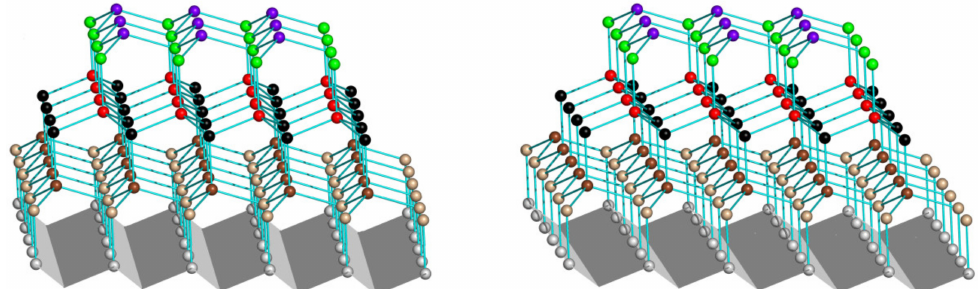
Figure 4. A stereo drawing of a piece of “normal” hexagonal ice (ice I h , [24]) on a corrugated underlying surface (highlighted in gray) fitted to basal planes of this piece, which are horizontal in this figure. Oxygen atoms are shown as balls. In different quasi-layers they are shown in different colors. Hydrogen atoms are not shown. Lines between O atoms correspond to O-H-O hydrogen bonds.